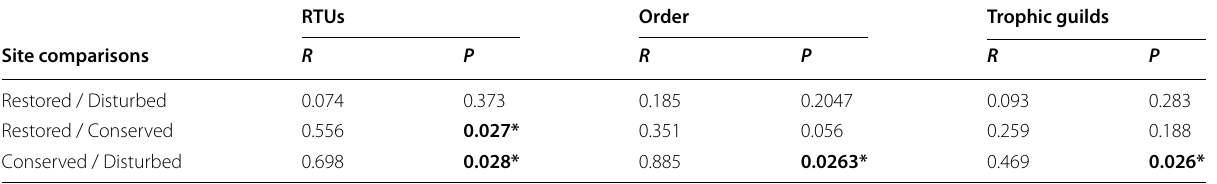
* significant differences =